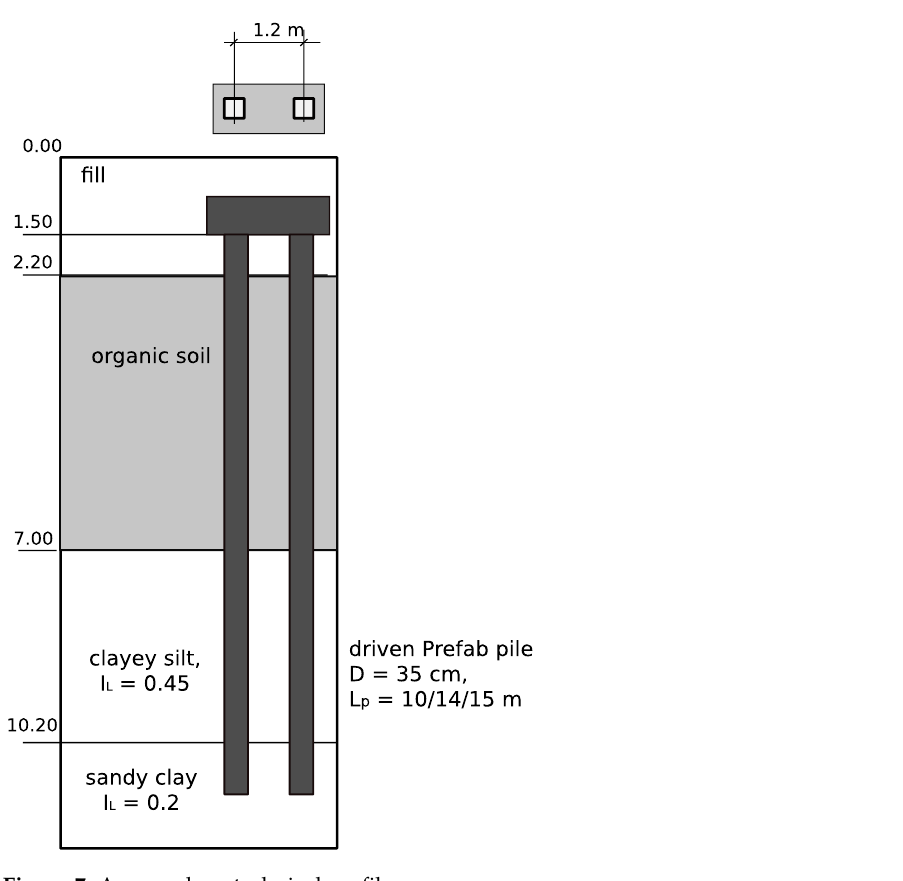
Figure 7. Assumed geotechnical profile. Table 1. Parameters adopted for the pile settlement calculations.